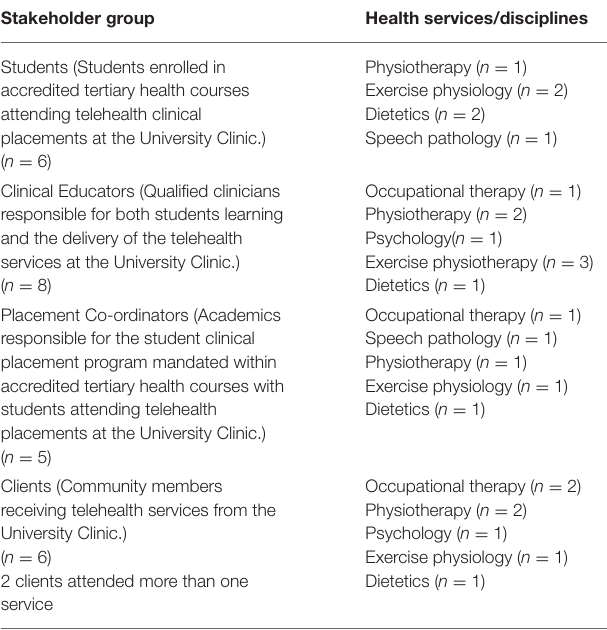
TABLE 1 | Disciplines Represented Within Each Stakeholder